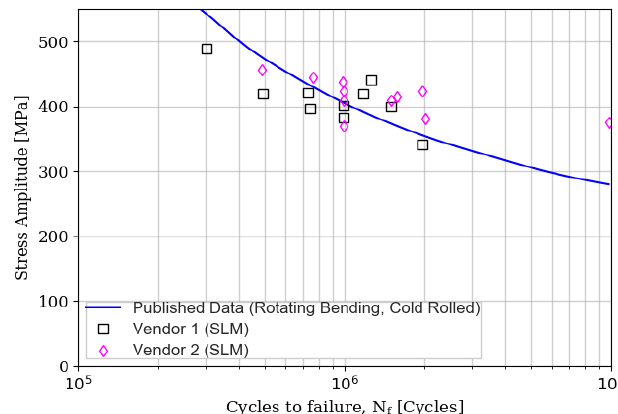
Figure 33: S-N curve showing the fatigue performance of SLM IN718 subjected to vibration bending loads and cold rolled IN718 subjected to rotating bending loads [77].